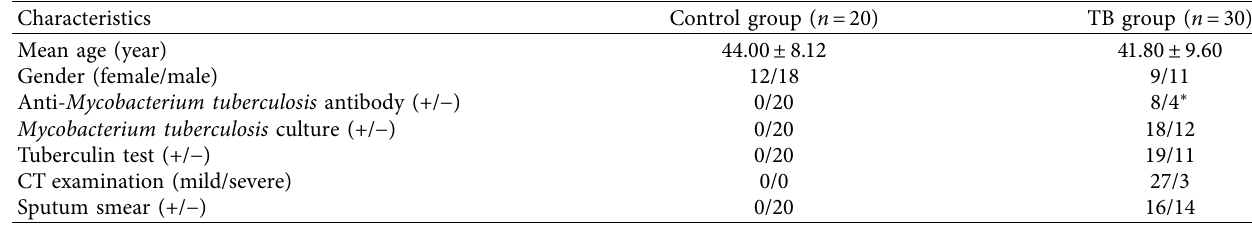
Table 1: Comparison of subjects’ characteristics between the TB and control